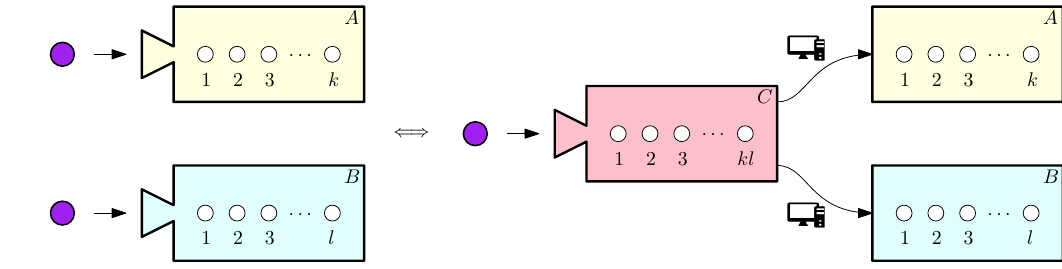
FIG. 3. The joint measurement of A and B is simulated by a third measurement C , followed by classical